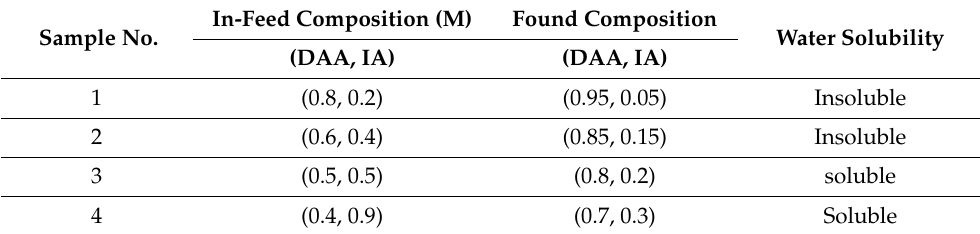
Table 1. Water solubility of various synthesized (DAA-IA) copolymers. In-Feed Composition Sample No.